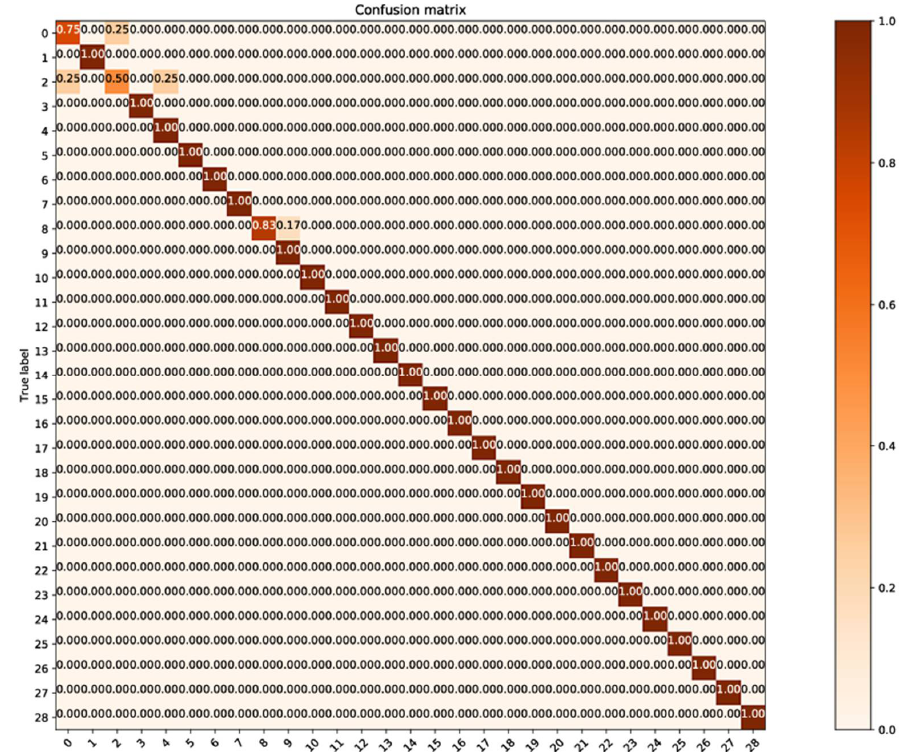
Figure 10. The confusion matrix in the case of the most favorable classification (90% of the training